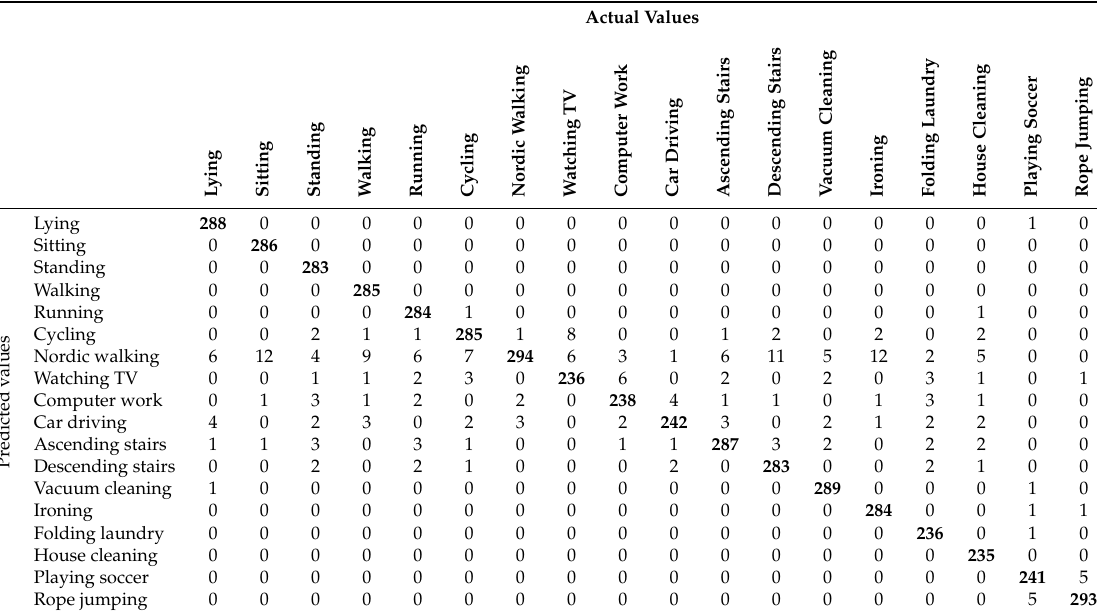
Table 16. Confusion matrix of the AHN classifier using the 15% noisy dataset.